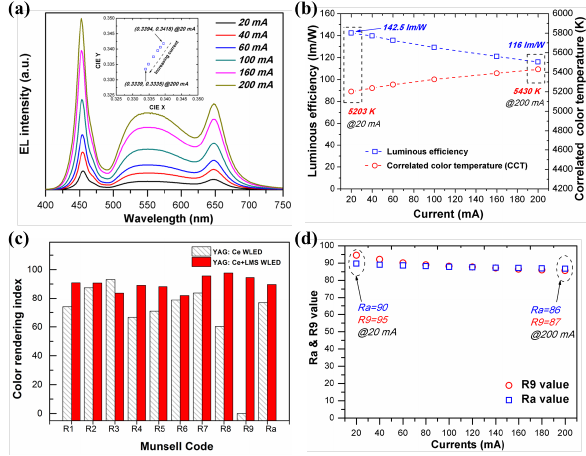
Figure 6: (a) EL spectra of the WLED operated under different for- ward bias currents. (Insert: CIE diagram of color coordinates) (b) Luminous eflciency and CCT of the WLED operated under different forward bias currents. (c) CRI of LMS-based WLED and commercial WLED based on YAG:Ce phosphor operated at 20 mA. (d) Evolution of Ra and R9 values under different forward bias currents of LMS- based WLED. EL: electroluminescence; LED: light emitting diode; CCT: correlated color temperature; CRI: color rendering index; LMS: luminescent microspheres; WLED: white light emitting